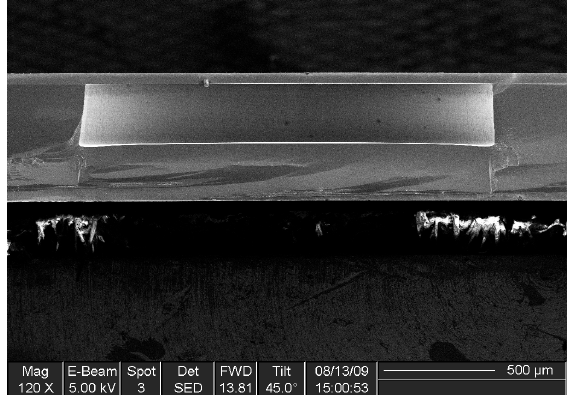
Figure 3. SEM image of a microfabricated SCS diaphragm (cross-sectional view).